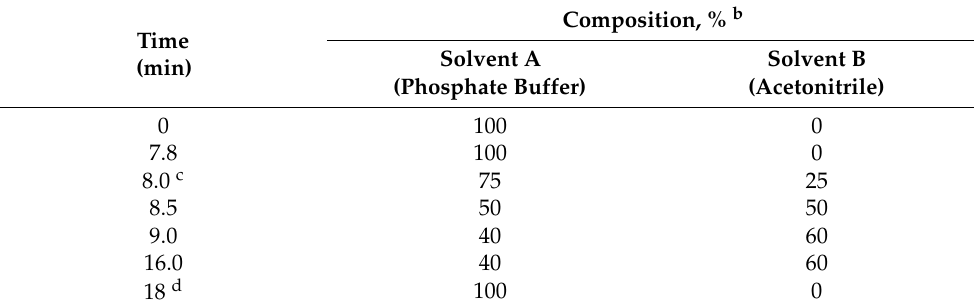
Table 1. Gradient composition a